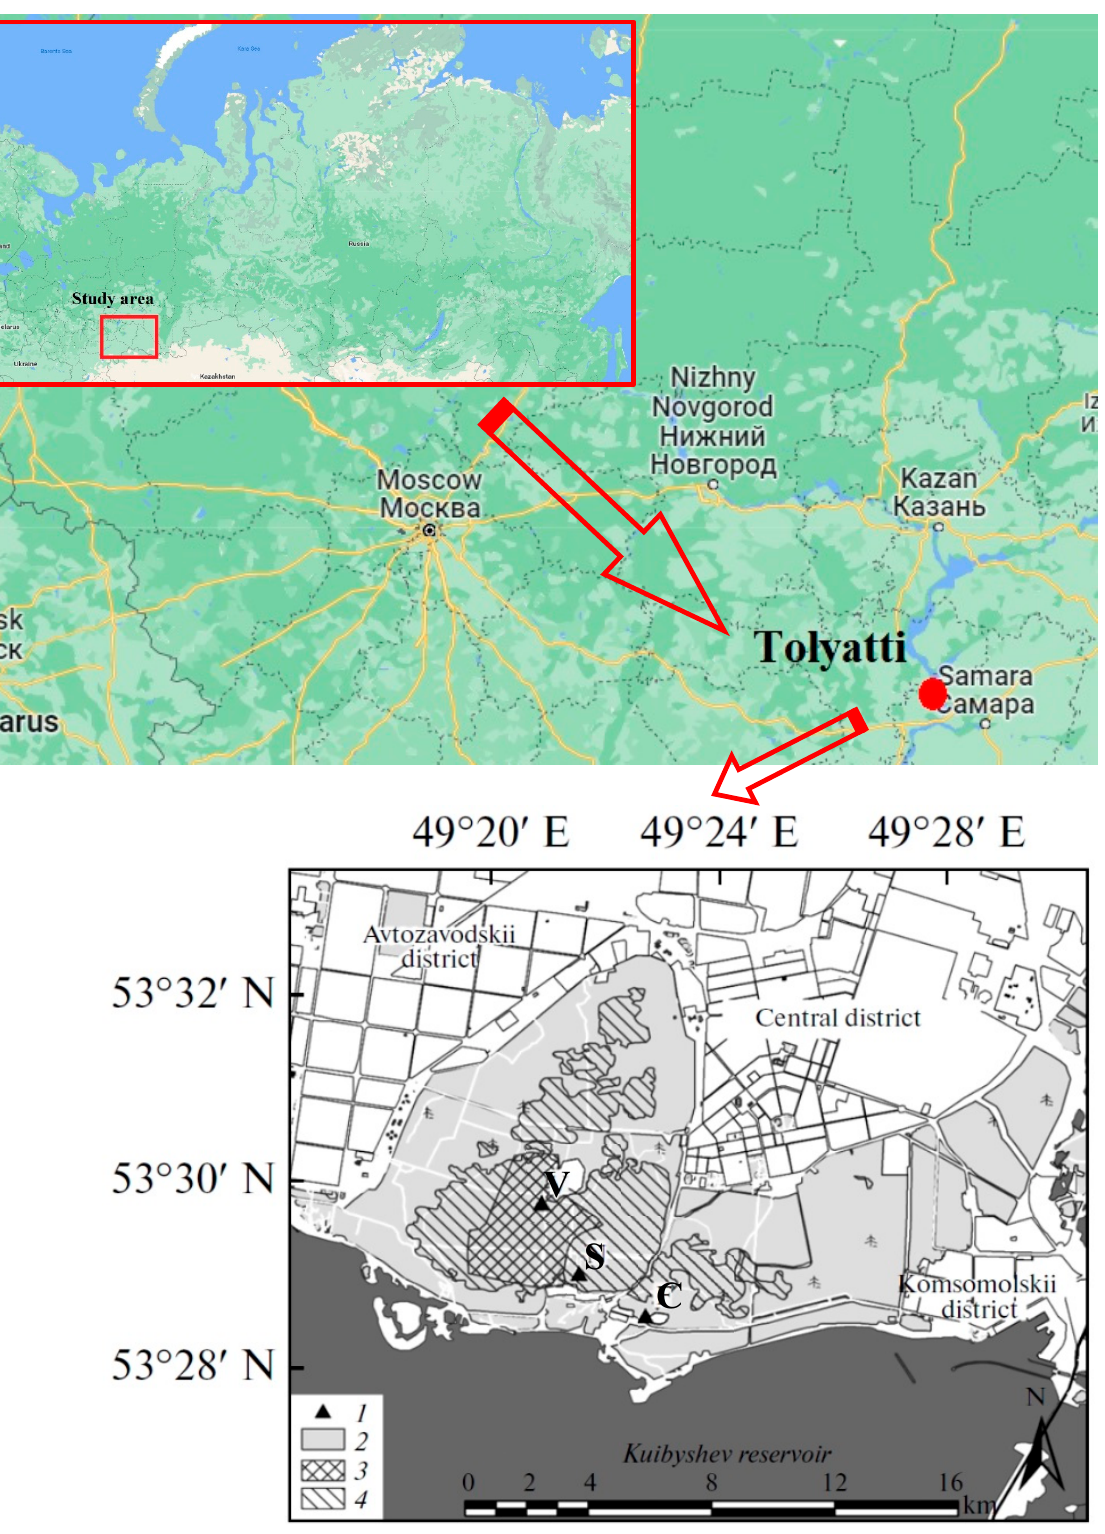
Figure 1. Stavropol pine forest damaged and destroyed by forest fires in 2010. Symbols: 1— ▲ — location of soil profiles (V—crown fire area, S—surface fire area, C—area on the territory unaffected by the fire); 2—forested areas (before the fire in 2010); 3—territories affected by crown forest fire; 4—territories affected by surface forest